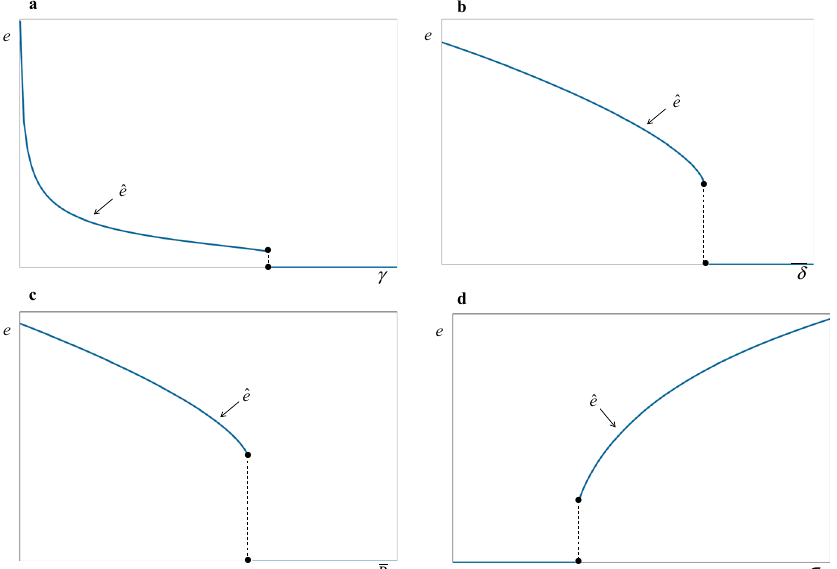
Fig. 3 Comparative statics. a Effect of cost of effort. b Effect of supervisory liquidation costs. c Effect of expected asset return. d Effect of volatility of asset